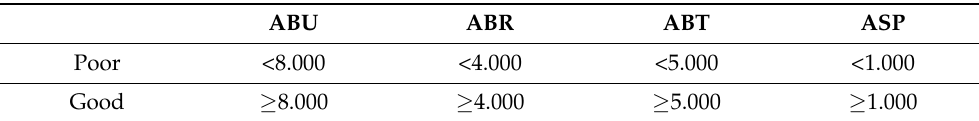
Table 7. Scoring criteria for respondents regarding their understanding towards different aspects of antibiotics based on median scores. ABU ABR